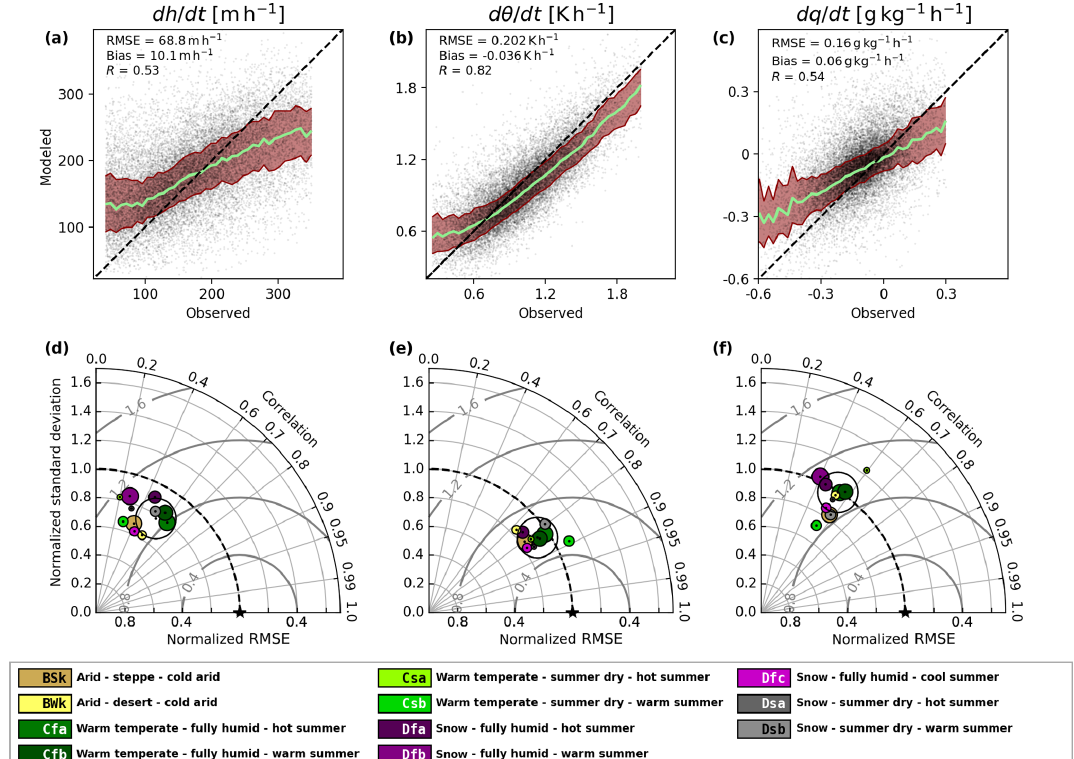
Figure 4. Model skill in reproducing diurnal changes in ABL properties. Shown are the tendencies of the mixed-layer height (d h/ d t ), potential temperature (d θ/ d t ) and specific humidity (d q/ d t ), which are assessed by comparison of model simulations against the IGRA sounding data between 1981 and 2015. Panels (a) – (c) show modeled versus observed data points (gray) and the corresponding median (green) and interquartile range (red) of the model. The 1 : 1 line is shown as a black dashed line. The Taylor plots indicate the overall model performance as open circles and the performance corresponding to each Köppen–Geiger climate class as colored bullets. Only climate regimes with more than > 200 soundings are illustrated. The size of the bullets is proportional to the amount of soundings for each particular climate